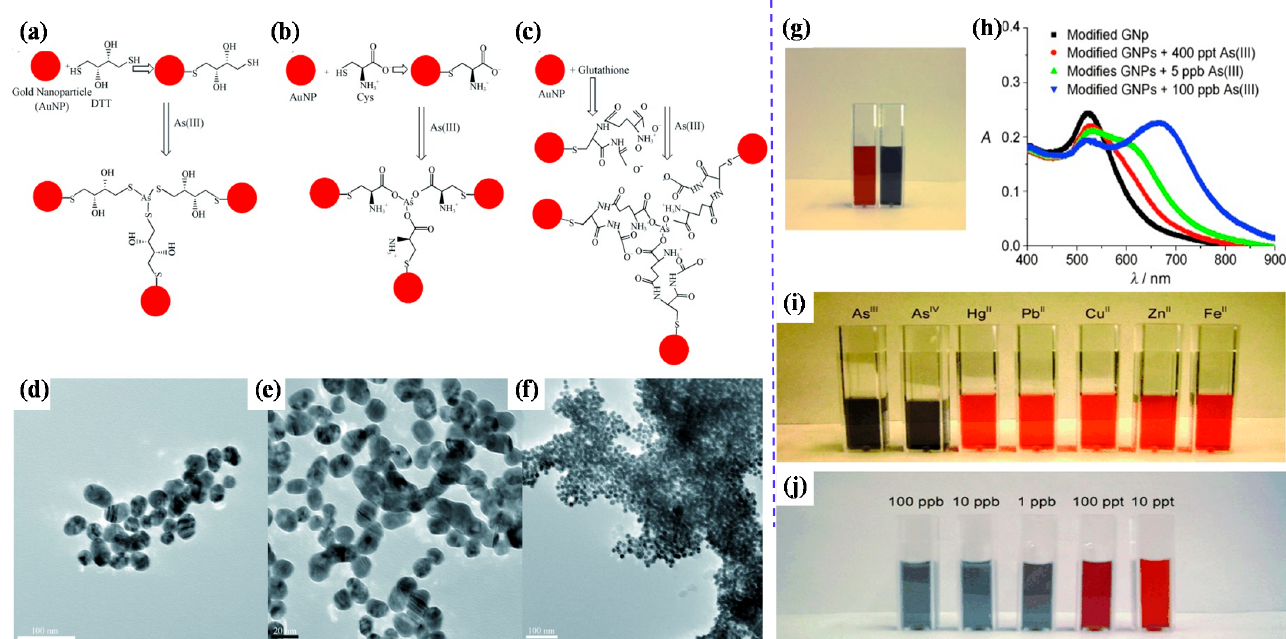
Figure 2. Representation of AuNP-based arsenic detection. ( a ) DTT-modified AuNPs; ( b ) Cys-modified AuNPs; ( c ) GSH-modified AuNPs; ( d ) TEM image showing GSH/DTT/Cys-modified AuNPs before the addition of arsenic (III); ( e ) TEM image demonstrating aggregation of GSH/DTT/Cys-modified AuNPs after addition of 80 ppb arsenic (III); ( f ) TEM image after the addition of 250 ppt arsenic (III); ( g ) photograph showing colorimetric change of GSH/DTT/Cys-modified gold nanoparticles upon addition of 800 ppb arsenic (III); ( h ) absorption profiles of modified gold nanoparticles before and after addition of arsenic (III) ions; ( i ) photograph showing colorimetric changes of GSH/DTT/Cys-modified gold nanoparticles in the presence of PDCA upon addition of various metal ions (5 ppb) and ( j ) different concentrations of arsenic (III) [61]. Copyright 2009, reproduced with permission from WILEY-VCH Verlag GmbH & Co. KGaA, Weinheim, Germany.